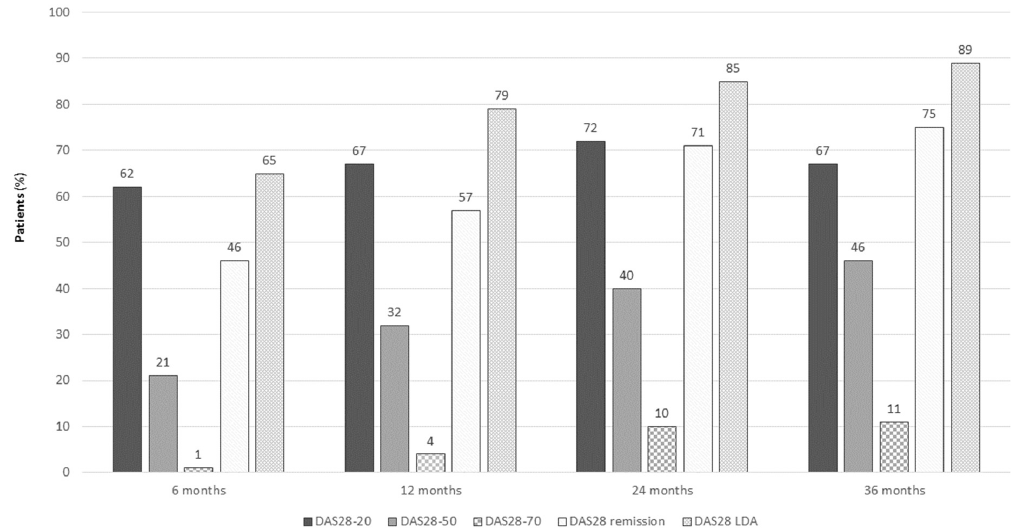
Figure 2. DAS28-20, DAS28-50, DAS28-70, DAS28 remission, and DAS20 LDA in SLE patients on belimumab at di ff erent timepoints.